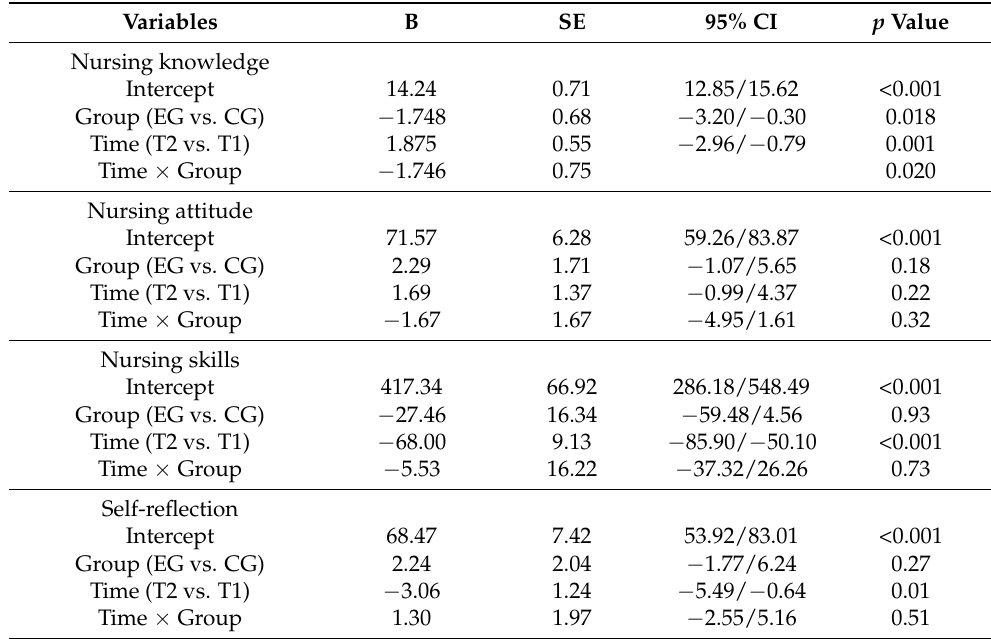
Table 3. GEE analysis of changes in nursing knowledge, nursing attitude, nursing skills, and self- reflection between experimental and control